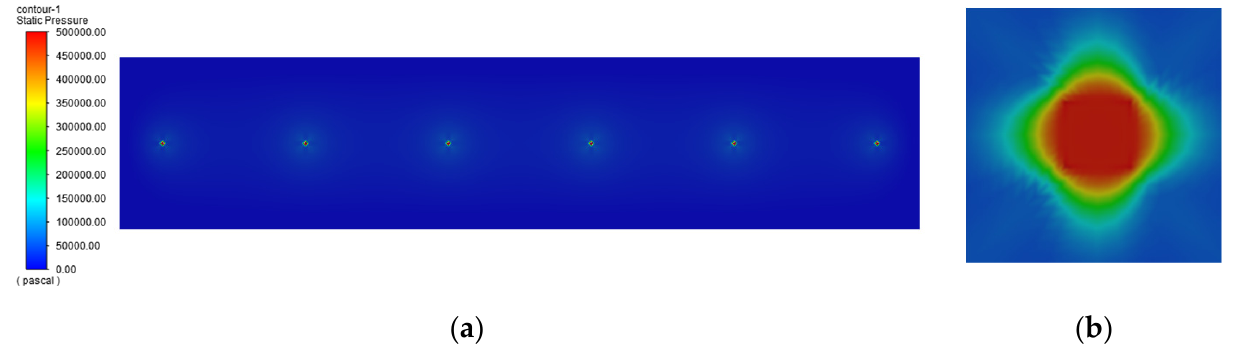
Figure 6. Dimensional parameters of air film. Table 1. Structural parameters of the model.